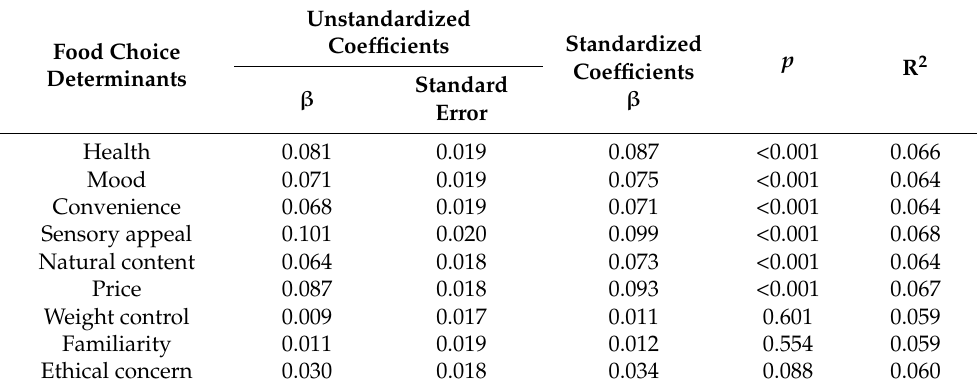
Table 5. Analysis of association between food choice determinants assessed by Food Choice Ques- tionnaire (FCQ) and meat/fish preference assessed by Food Preference Questionnaire (FPQ) (model adjusted for sex and age) within the population of the second phase of the Polish Adolescents’ COVID-19 Experience (PLACE-19) Study ( n = 2425).